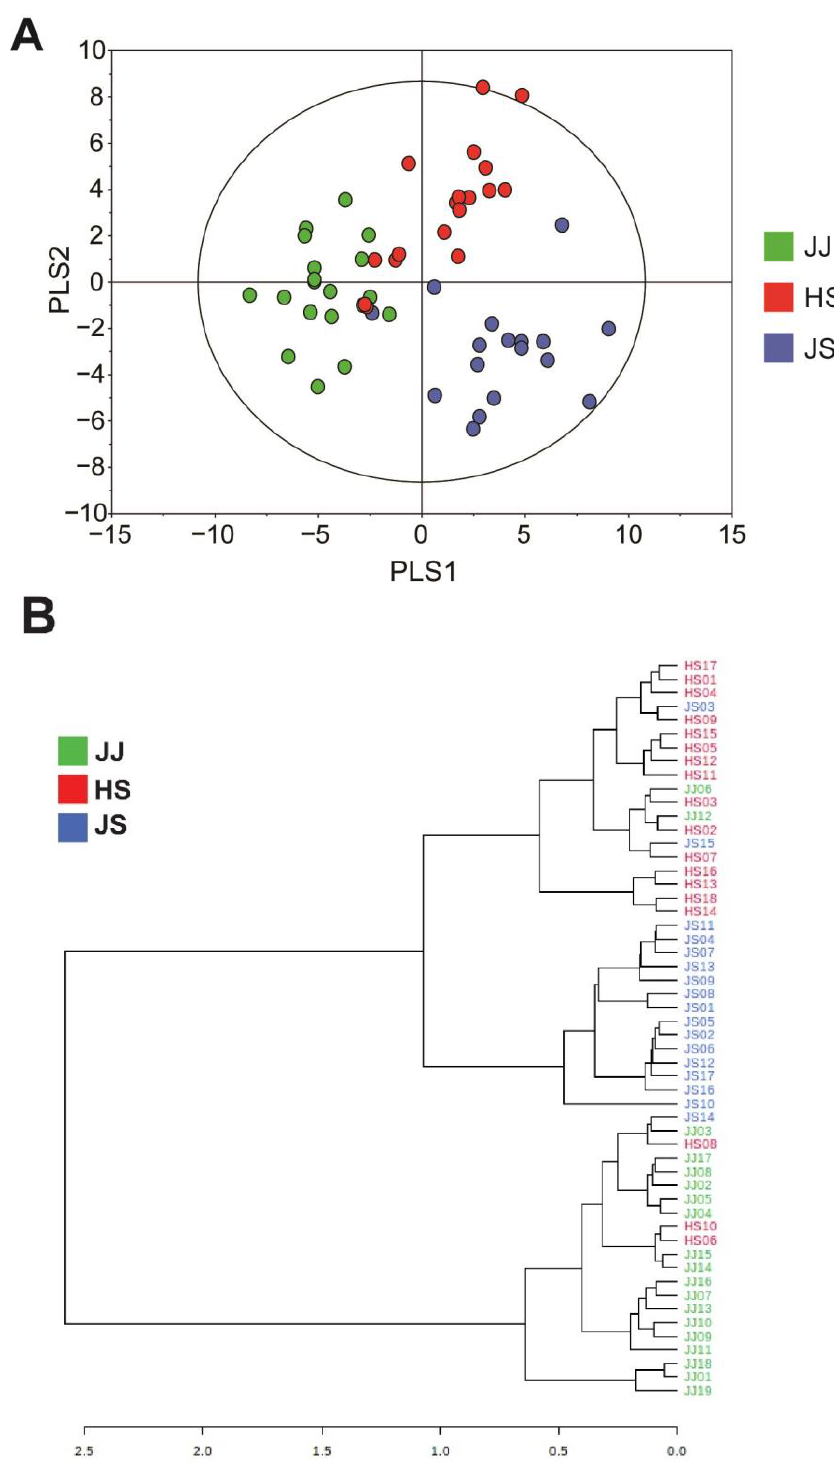
Figure 1. PLS-DA score plot ( A ) and HCA ( B ) derived from identified metabolites from C. lanceolata samples obtained from three different geographical